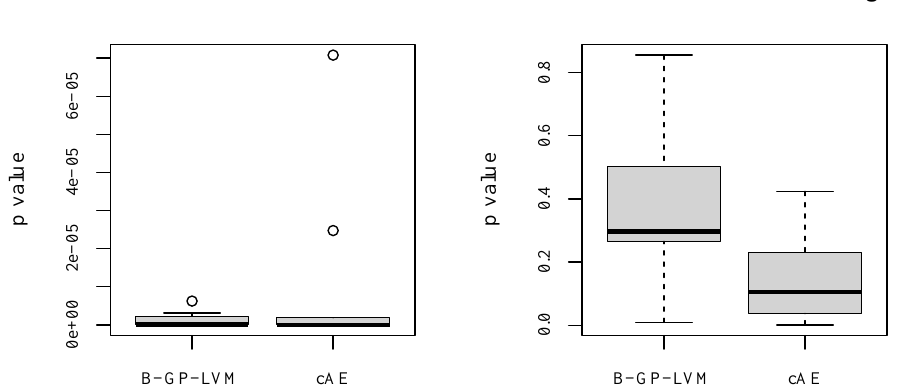
Figure 6. McNemar test for Daucus carota ( left ) and Beta vulgaris ( right ). Assuming α = 0.05, we see that for Beta vulgaris the CNN error rate does not differ significantly from the proposed unsupervised models. However, we observed a significant error rate difference for the Daucus carota data set. Assuming α = 0.05, we can reject H 0 : the error rate for both models are equal for Beta vulgaris but not for Daucus carota .